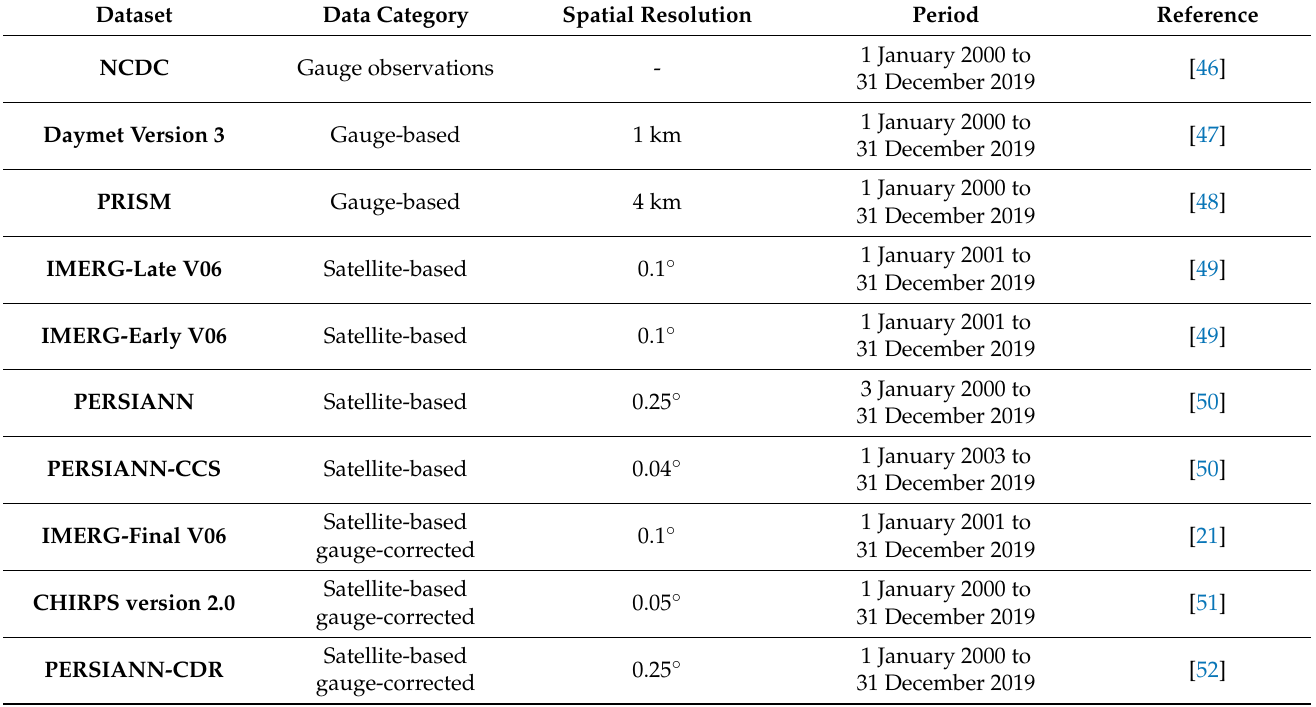
Table 1. Gridded precipitation datasets used in the SWAT hydrological